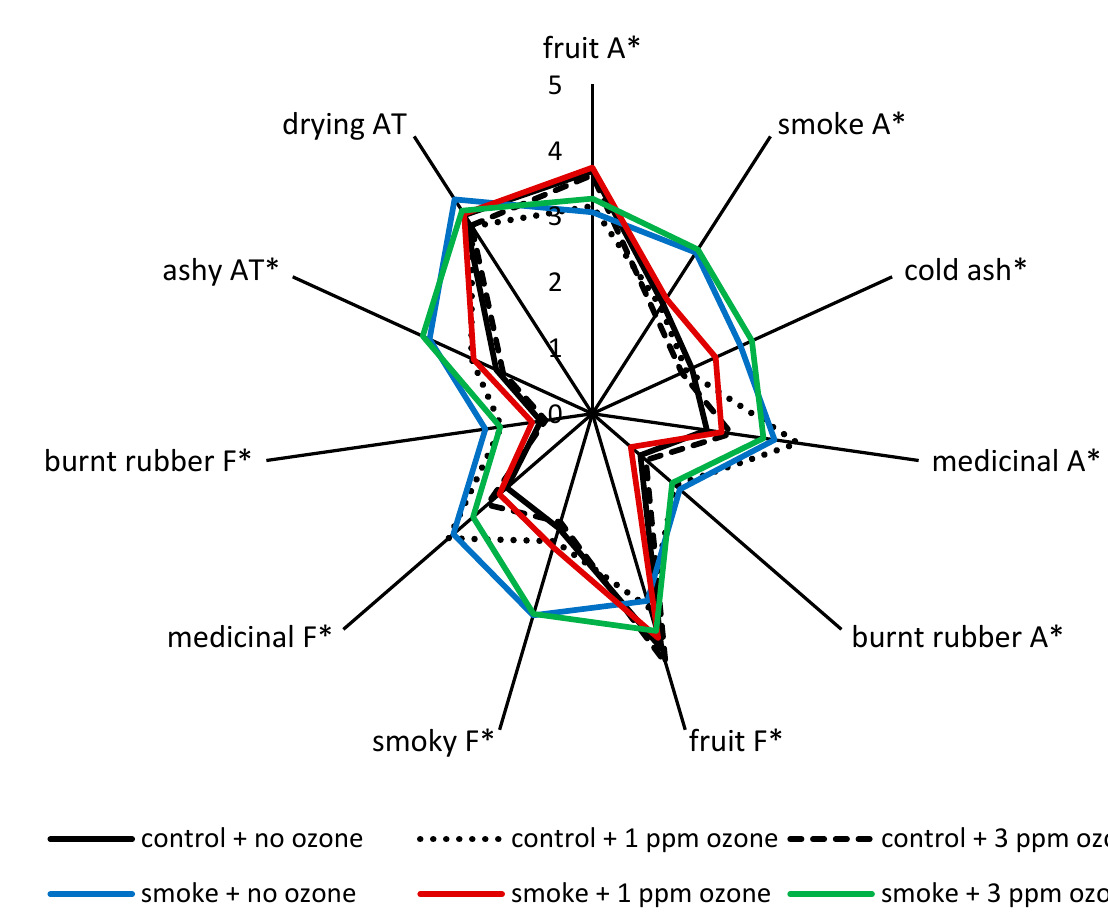
Figure 1. Sensory profiles of wines made from control and smoke-affected grapes, with and without post-harvest ozone treatment (at 1 ppm for 24 h or 3 ppm for 12 h); A = aroma; F = flavor; AT = aftertaste. Values are mean ratings of one blended wine per treatment, presented to 50 judges; * indicates statistical significance ( p = 0.05, one-way ANOVA). Smoke exposure occurred at approximately 7 days post ‐ veraison.